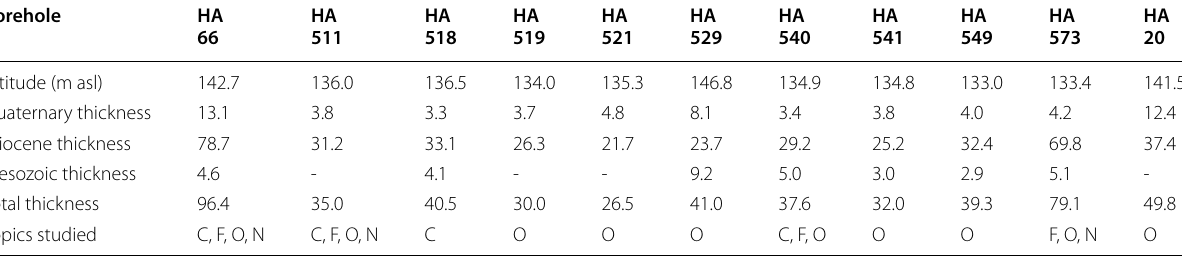
Table 1 Basic data of the 11 studied drillings; measurements in meters; m asl: meters above sea level; topics studied at the respective borehole: C: carbonate facies, F: foraminifers, O: ostracodes, N: calcareous nannoplankton Borehole HA 66 Altitude (m asl) 142.7 Quaternary thickness Miocene